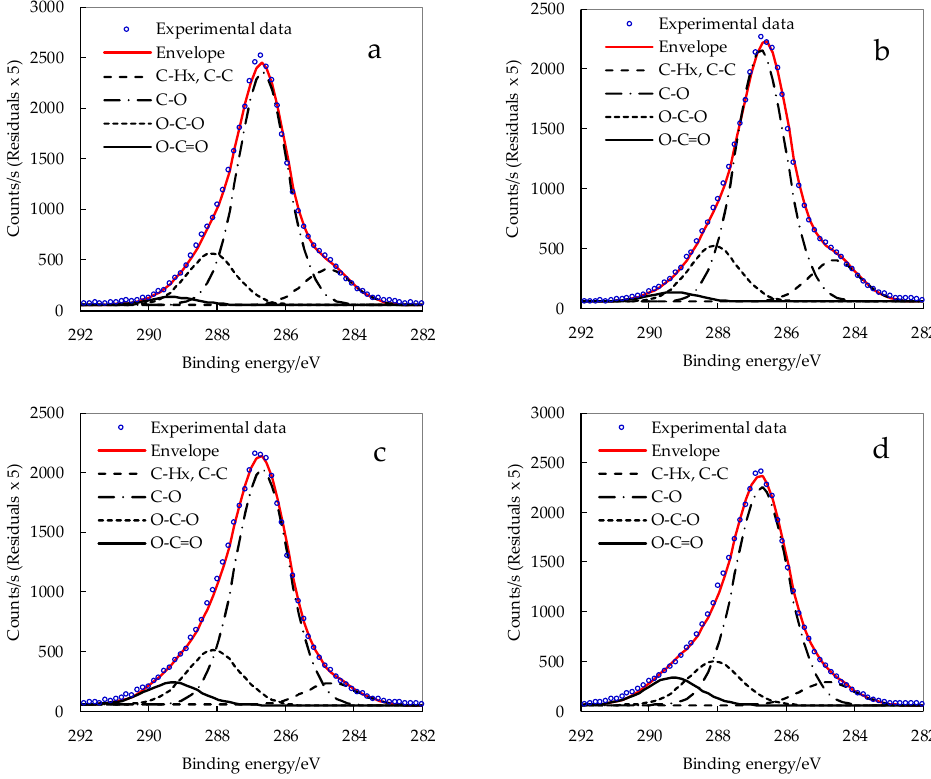
Table 2. Atomic concentrations from XPS spectra and a resolved carbon C 1s peak for alkali treated cellulose (Avicel NaOH), CNCs obtained in phosphoric acid solution with concentration of 76 wt.% (CNC_P76) and surface modified CNCs at different molar ratio of succinic anhydride to cellulose hydroxyl groups.